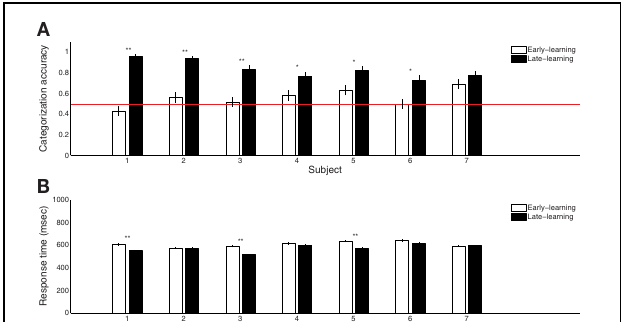
FIGURE 2 | Summary of behavioral category learning performance. (A) Categorization accuracies during the early (first 100 trials) and late (final 100 trials) periods of the learning experiment. (B) Reaction times during trials from the same periods. “ ∗ ” and “ ∗∗ ” indicate significance at p < 0 . 05 and p < 0 . 005, respectively, with Bonferroni corrections.